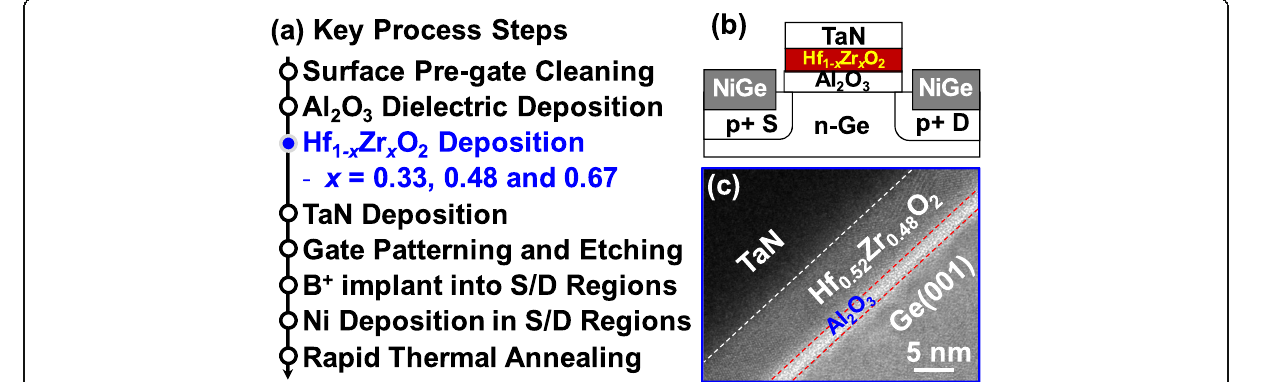
Fig. 1 ( a ) Key process steps for the fabrication of Ge NCFETs with the different Zr compositions in Hf 1 − x Zr x O 2 ferroelectrics. ( b ) Schematic of the fabricated NC transistor. ( c ) TEM image of the gate stack of NC device illustrating the 7 nm H 0.52 Zr 0.48 O 2 layer and 2 nm Al 2 O 3 layer